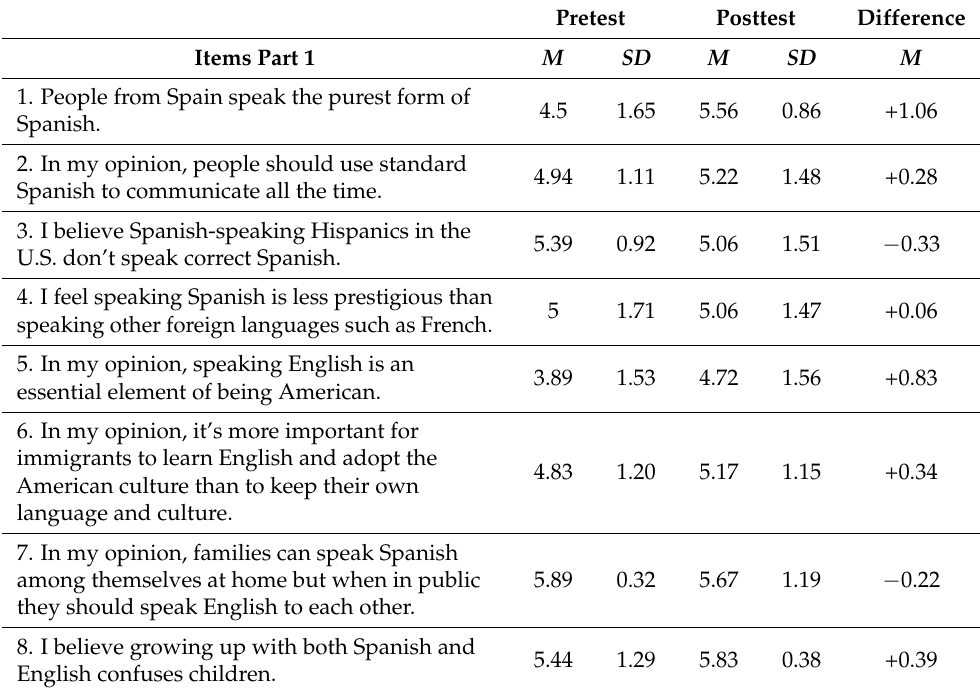
Table 3. Mean and Standard Deviation Results for CLA Questionnaire Part 1 ( N =